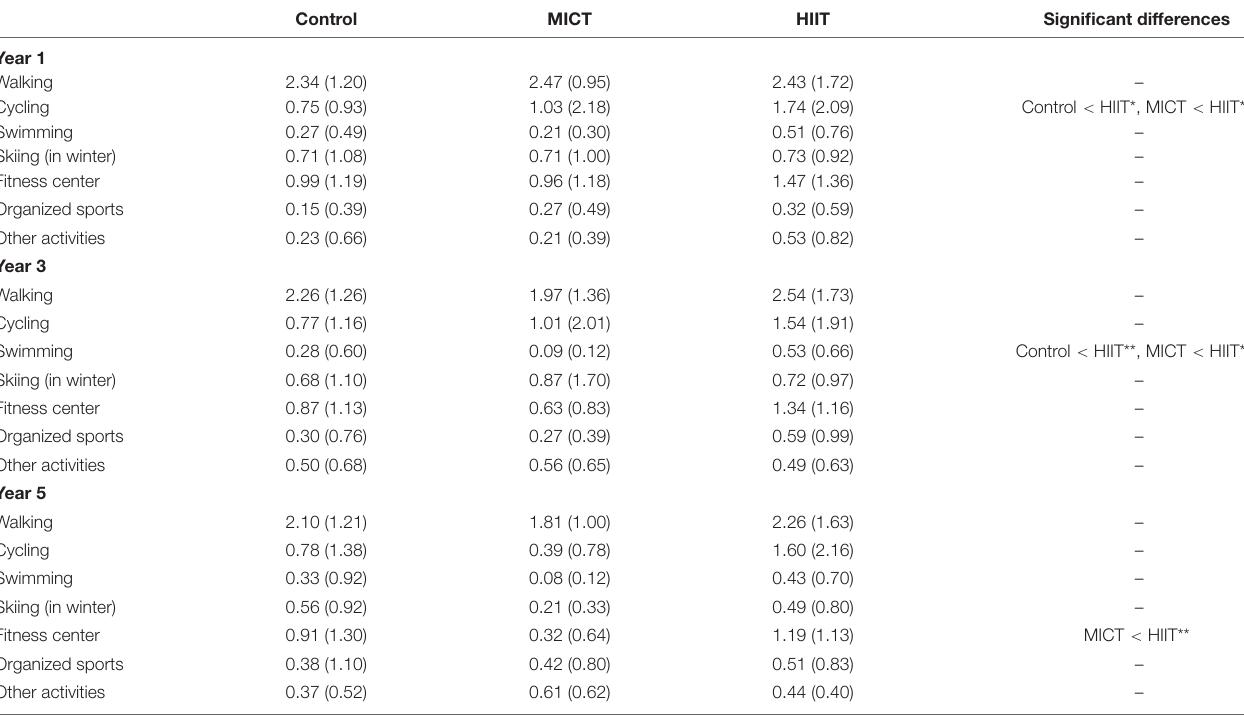
TABLE 3 | Frequency of the performed exercise activity in the control, MICT, and HIIT groups at 1-, 3-, and 5-year